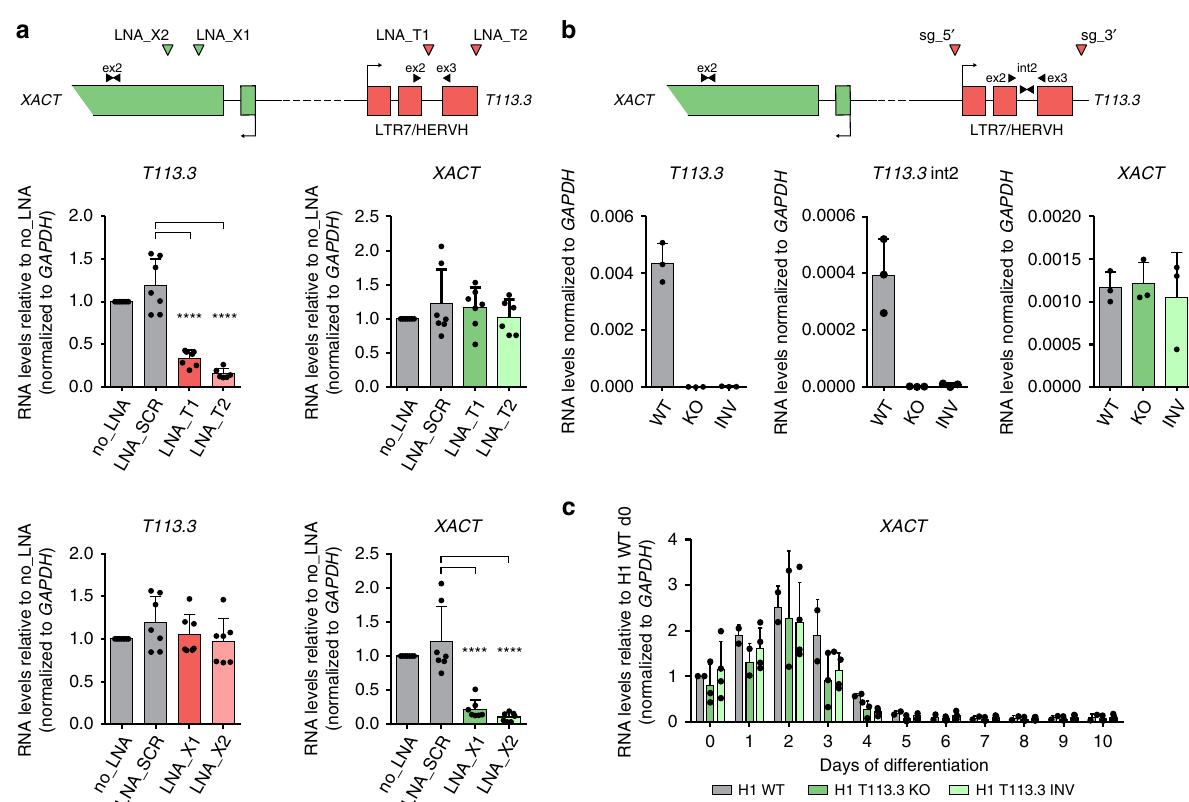
Fig. 4 Neither T113.3 gene nor T113.3 RNA regulate XACT expression. a Scheme of XACT and T113.3 loci showing the position of the LNA GapmeRs used for XACT (green arrows) and T113.3 (red arrows) KD, and the position of the primers used for the RT-qPCR (black arrows). RT-qPCR analysis of T113.3 and XACT expression in cells transfected with LNA GapmeRs targeting T113.3 (top panels) or XACT (bottom panels) (minimum of six replicates per condition). b Scheme of the XACT and T113.3 locus showing the guide positions (red arrows) used for the deletion of the T113.3 gene and the position of the primers used for RT-qPCR (black arrows). RT-qPCR analysis of T113.3 and XACT expression in H1 WT, T113.3 KO, and INV hESC clones. n = 3. c RT-qPCR analysis of XACT expression during a 10-day undirected differentiation of H1 T113.3 WT, KO, and INV hESC lines. n ≥ 3. Error bars represent the SD. Statistical signi fi cances were determined using a one-way ANOVA (all tests compared to LNA_SCR). * P -values<0.05, ** P -values<0.01, *** P -values<0.001, and **** P